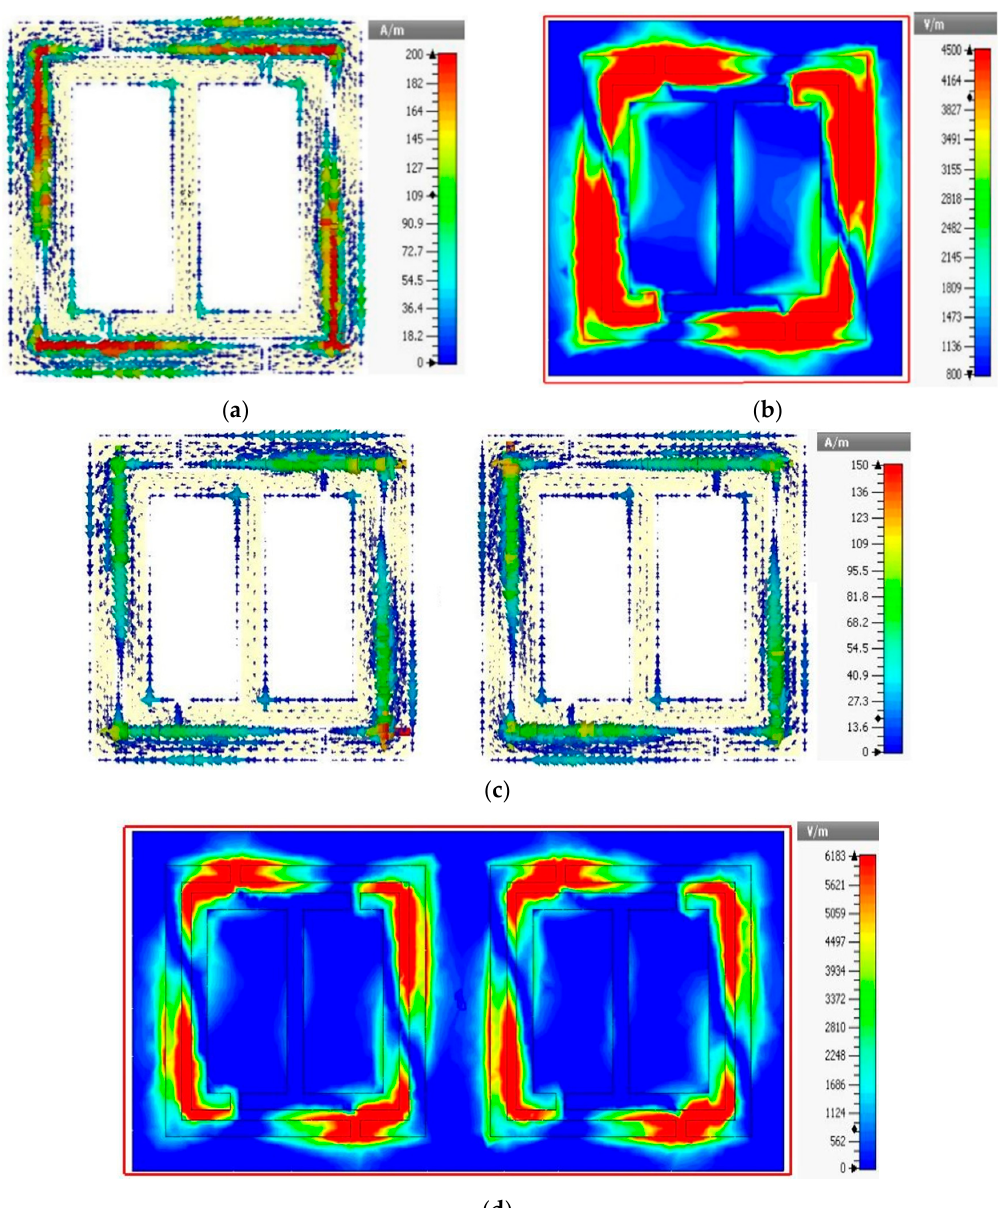
Figure 7. Surface current at 12.94 GHz of: ( a ) single unit cell and ( c ) 1 × 2 array structure. Numerical electric field distribution in the XY plane at 12.94 GHz for: ( b ) single unit cell and ( d ) 1 × 2 array structure.